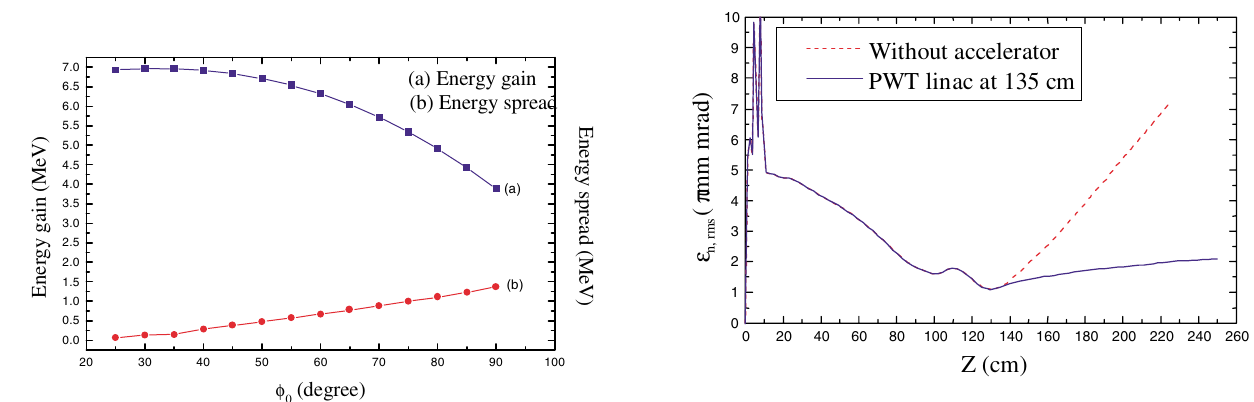
FIG. 9. (Color) PARMELA simulations for transverse emittance variation with distance, with a solenoid magnet field of 4.5 kG at 16 cm from cathode and a 4-cell PWT linac at 135